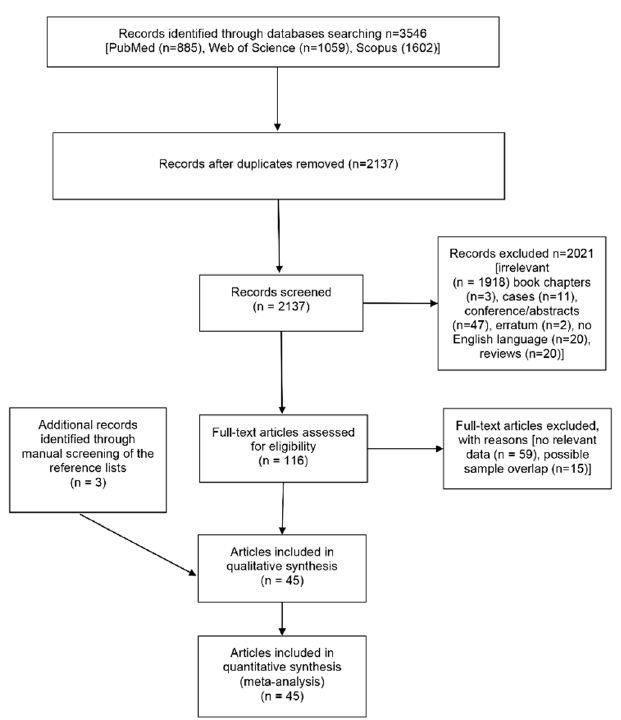
Figure 1. The flowchart presenting the selection procedure of eligible studies.